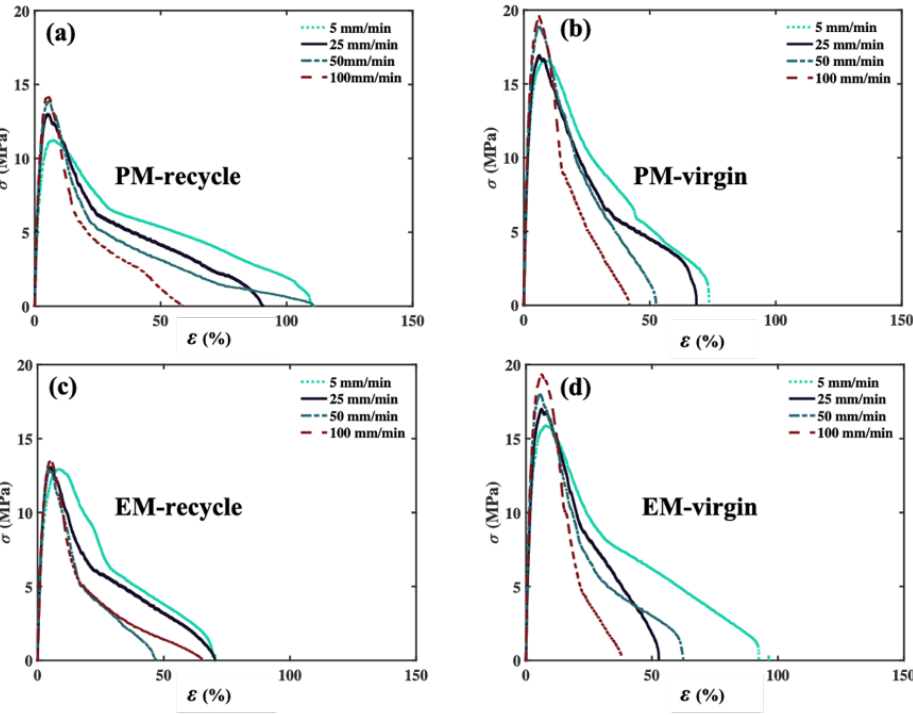
Figure 8. Stress–strain curves at different strain rates for the virgin and recycled HDPE prepared by: ( a , b ) powder mixing (PM) and ( c , d ) extrusion mixing (EM).